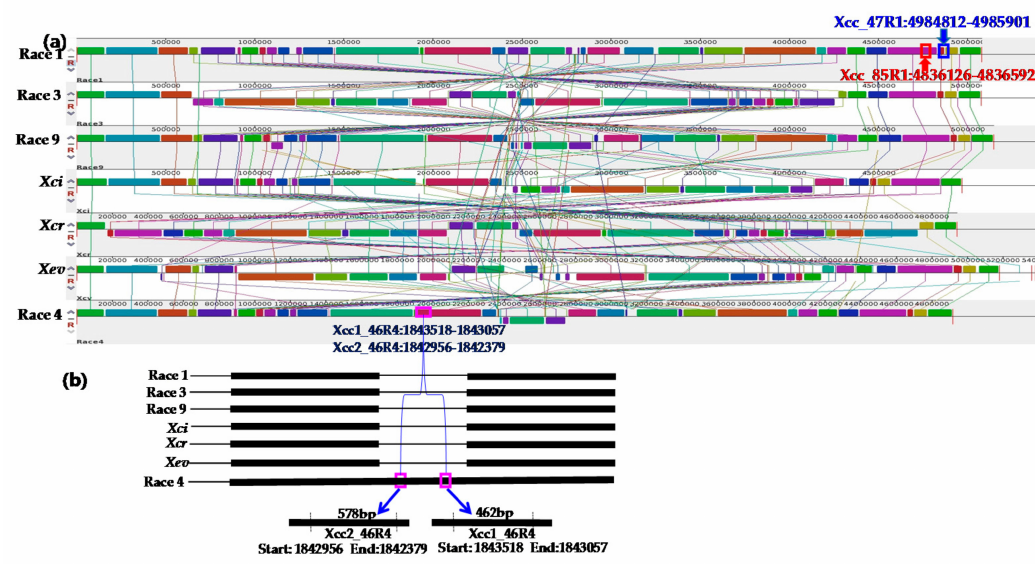
Figure 1. Alignment of whole genome sequences of four Xanthomonas campestris pv. campestris races, two other X. campestris pathovars ( incanae and raphani ) and another Xanthomonas species ( X. euvesicatoria ). ( a ) A multiple alignment of whole-genome of four races (races 1, 3, 4 and 9) of Xcc and three X. campestris pathovars/species ( Xci , Xcr and Xev ) consists of several rearranged pieces larger than 1 Kb. Each genome is laid out horizontally with homologous segments (LCBs) outlined as colored rectangles. Regions inverted relative to race 1 (B100) are set below those that match in the forward orientation. Lines collate aligned segments between genomes. Average sequence similarities within an LCB, measured in sliding windows, are proportional to the heights of interior colored bars. Large sections of white within blocks and gaps between blocks indicate lineage specific sequence; ( b ) Comparative homology among four races and three X. campestris pathovars/species using Mauve tool, version 2.4.0 and Geneious software (Free trial